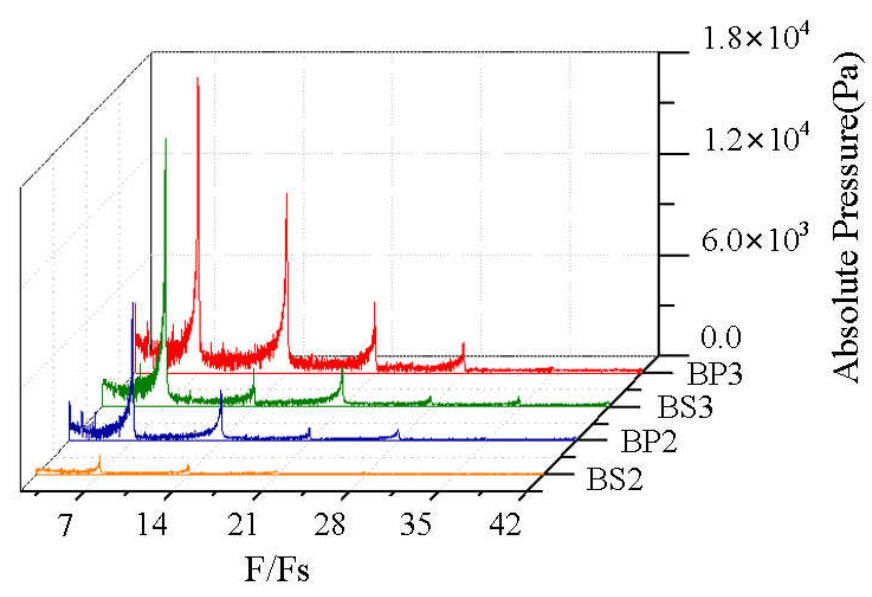
Figure 16. Spectrum of the amplitude of fluctuations in pressure at the impeller.